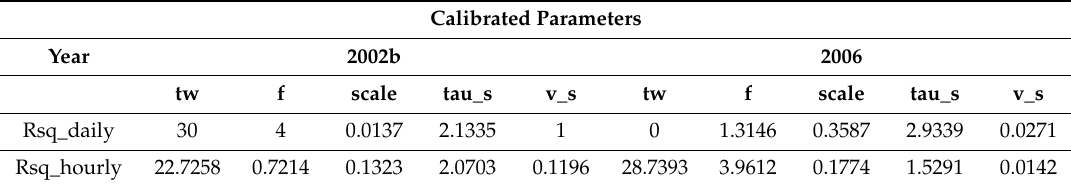
Table 3. Calibrated parameters for the 2002b and 2006 flood events with di ff erent time aggregated objective functions in the Zhidan watershed.